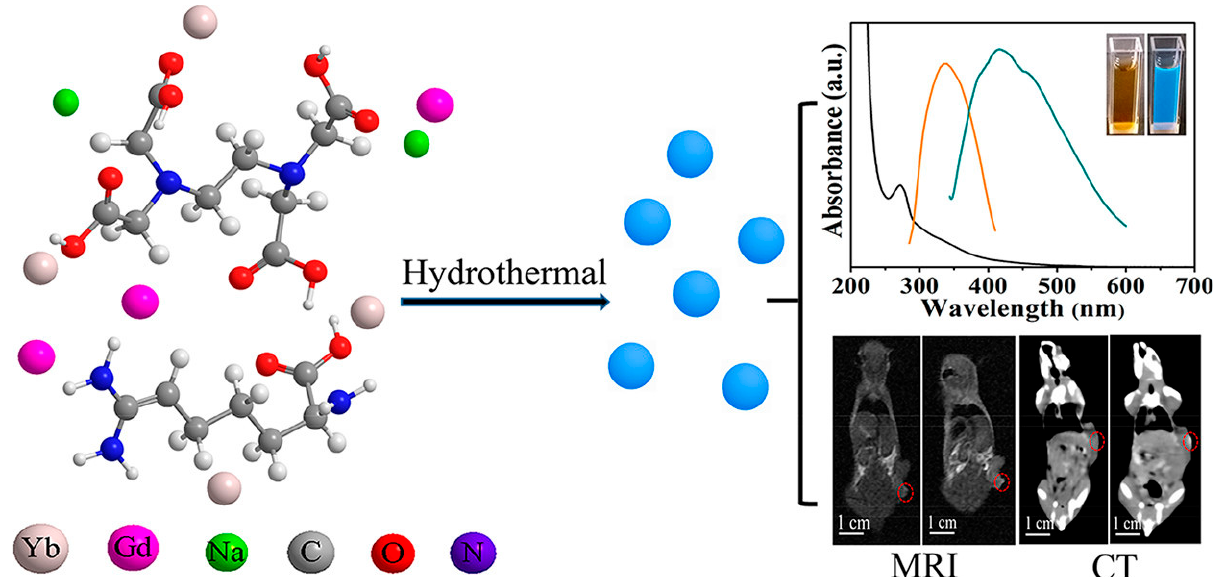
Figure 5. Schematic representation of preparation of Gd/Yb@CDs, UV-visible spectrum of doped carbon dots with optical metaphors under 365 nm UV and daylight, and finally, MR and CT images of cancer region observed pre- and post-intravenous administration for 5 h and 24 h, respectively. Reproduced with permission [139]. Copyright 2018, ACS. Table 3. Multimodal imaging properties of heteroatom/metal CNDs.